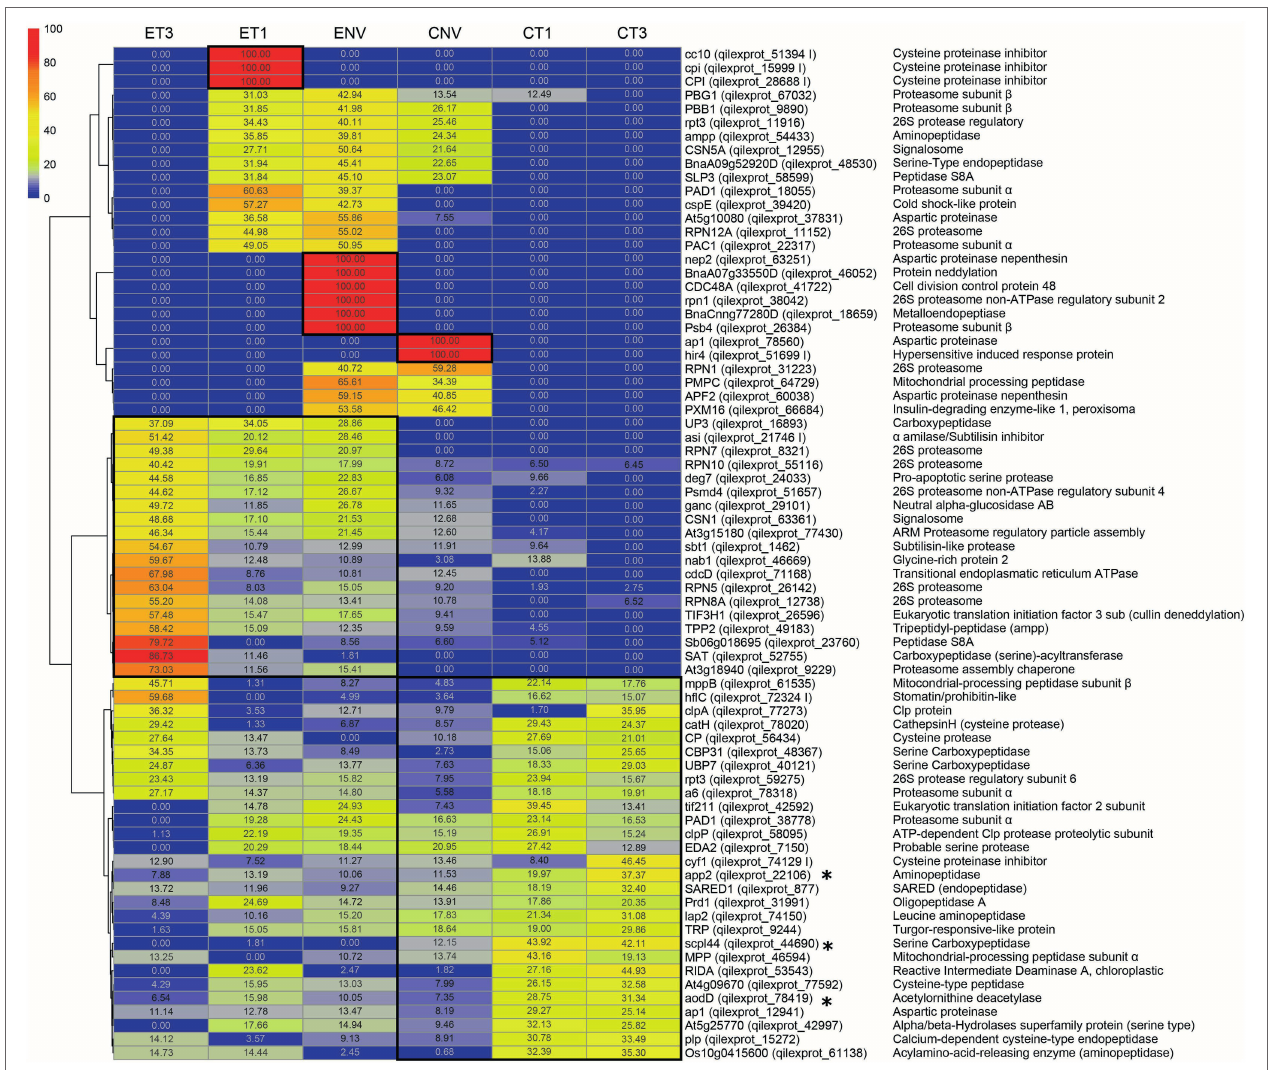
FIGURE 2 | Proteases and protease inhibitors heatmap included in the top300 loadings of PCA and Venn specific tissue/stage protease. E, embryo axis. C, cotyledon. NV: Nongerminated acorns after 4 weeks of germination. T1: mature acorns prior to germination. T3: germinated acorns when root tip size reached 6.5 mm. * proteases present in both the first and second PC. Numbers in each cell represent the normalized abundance of the proteins found in each treatment. This abundance is reflected in the color scale